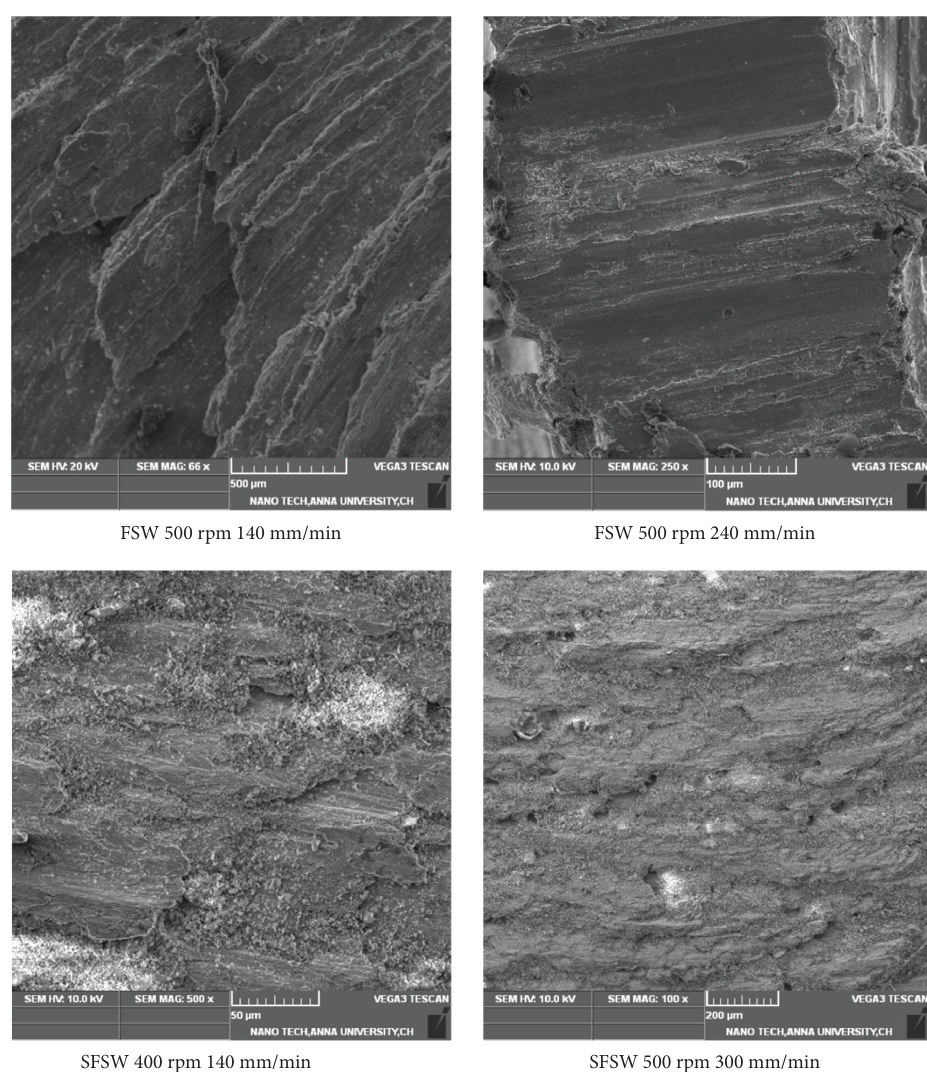
Figure 9: Scanning electron microscopic images of welded